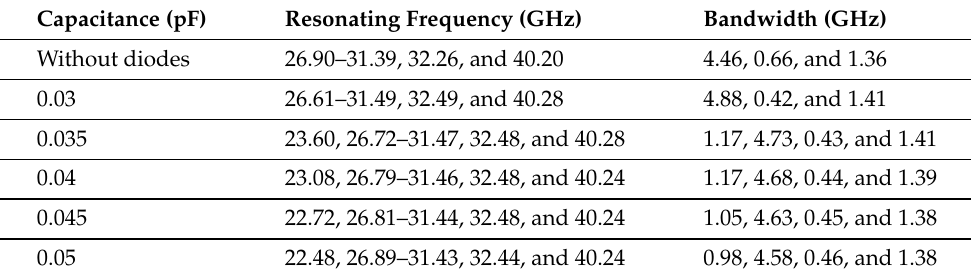
Table 3. Summary of return loss and bandwidth